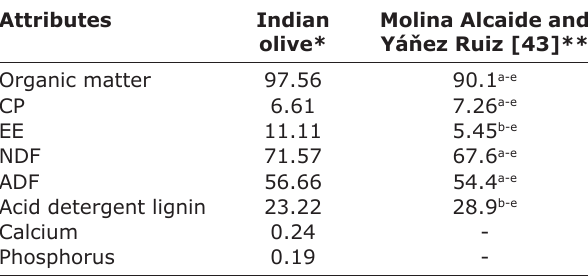
Table-4: Chemical composition (% DM) of Indian olive cake in comparison with European olive cake Attributes